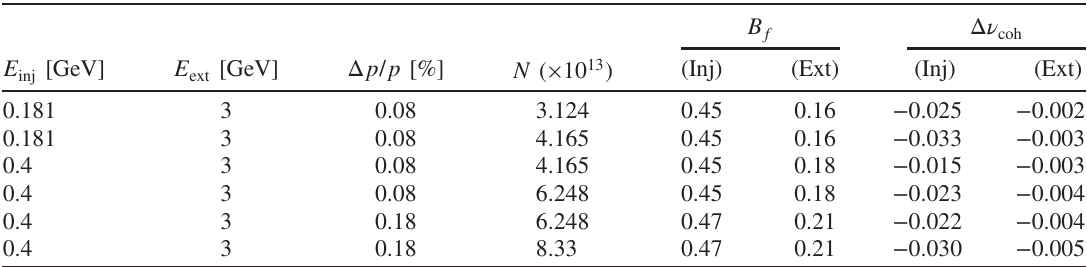
TABLE III. Estimated values of coherent tune shift Δ ν beam intensities considered in the present study. The measured rms momentum spreads ( Δ p / p ) of the injected beam used in the simulations are also